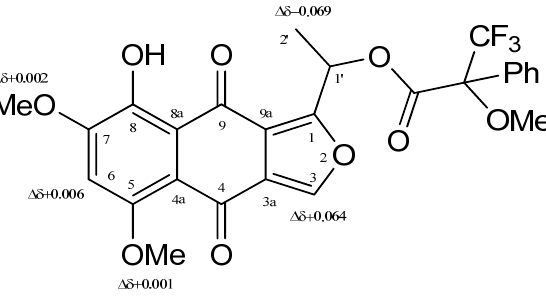
Figure 5. Structures of 1’ ‐ O ‐ S ‐ and 1’ ‐ O ‐ R ‐ MTPA of 3 ( 6 and 7 , respectively), reporting the Δδ values obtained by comparison of each proton